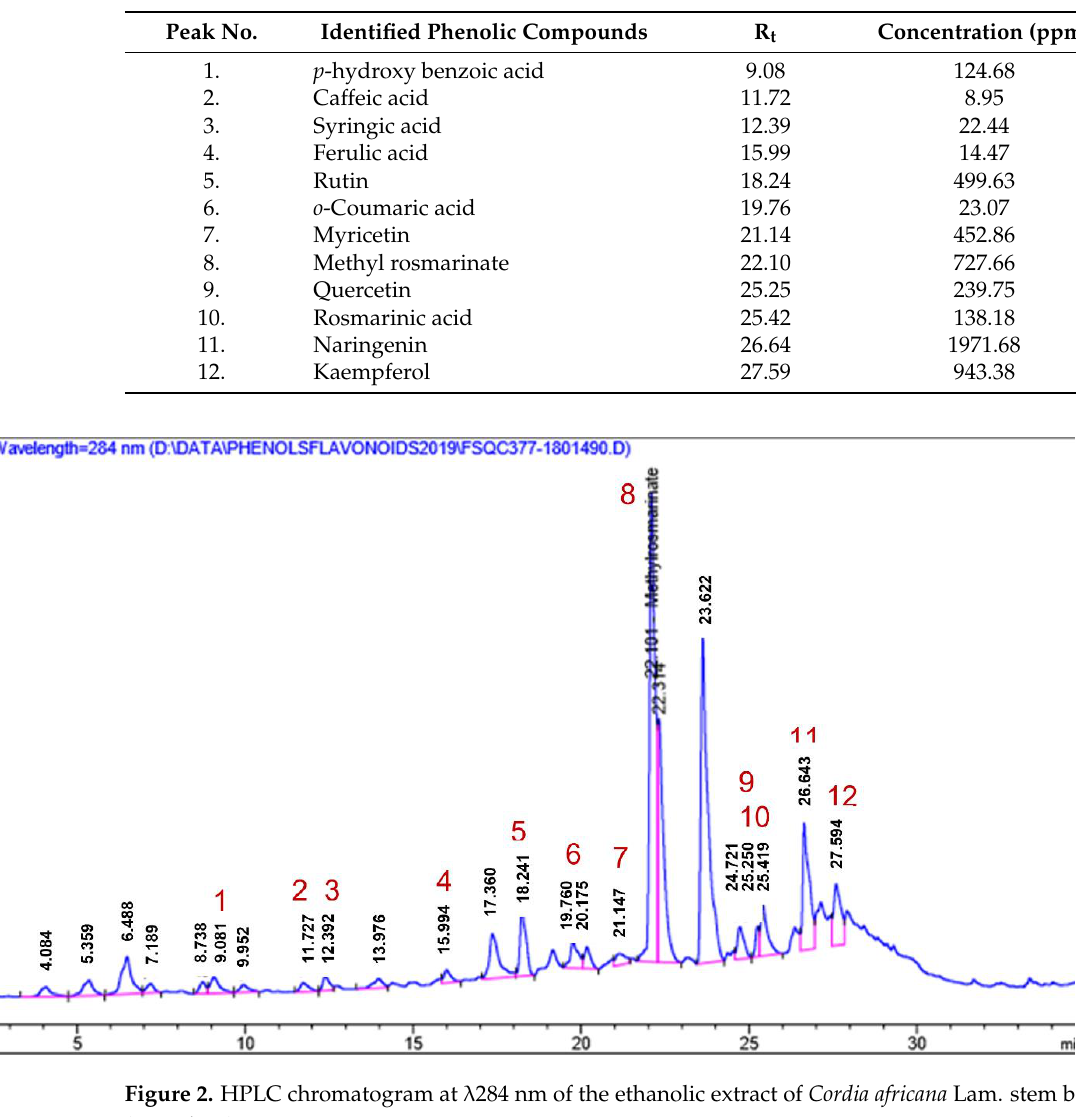
Table 2. Mean MIC ( μ g/mL ± SD) values of Cordia africana Lam. stem bark ethanolic extract and the isolated rosmarinic acid (RA) and methyl rosmarinate (MR) against H. pylori and methicillin-re- sistant Staphylococcus aureus (MRSA). H. pylori